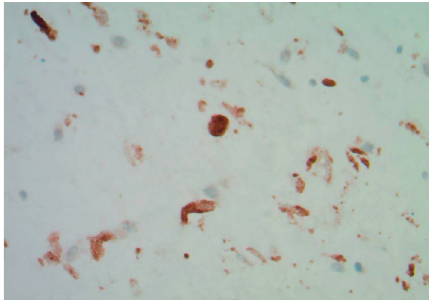
Figure 1: Immunohistochemical staining for HSV 1 and 2 con- firms the presence of the virus (Cell Marque, rabbit polyclonal).